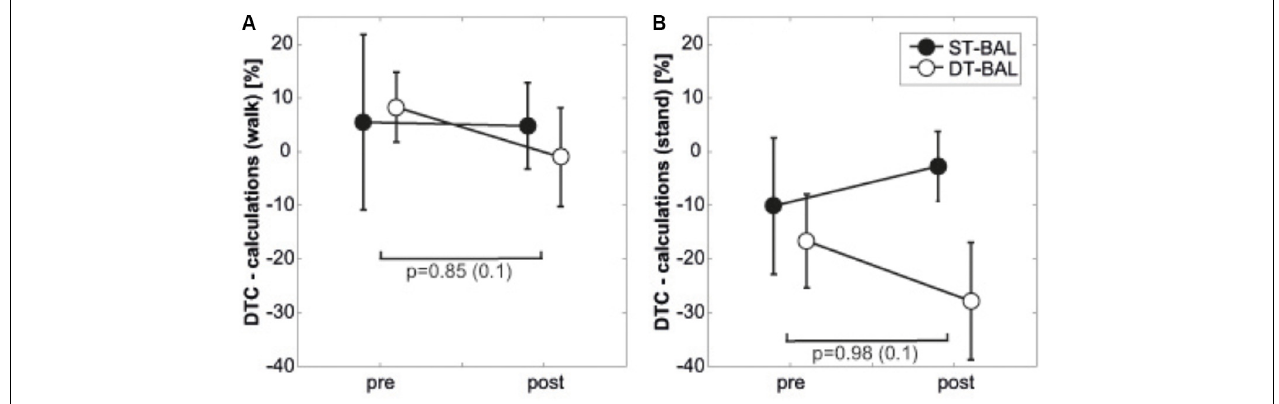
FIGURE 3 | Dual-task costs for secondary task pre and post intervention, displayed separately for (A) walking, (B) standing. Values in brackets represent Cohen’s d ; DTC, dual-task costs; DT-BAL, dual-task balance training group; ST-BAL, single-task balance training